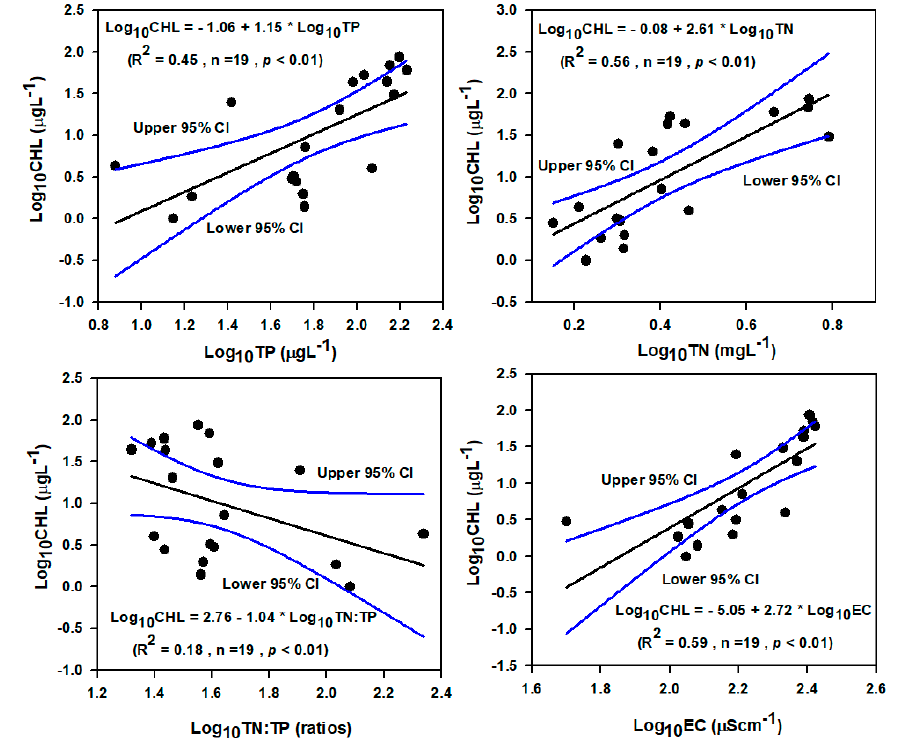
Figure 4. Empirical Relationship among TP, TN, TN:TP, and CHL. (TN—total nitrogen, TP—total phosphorus, CHL—chlorophyll).